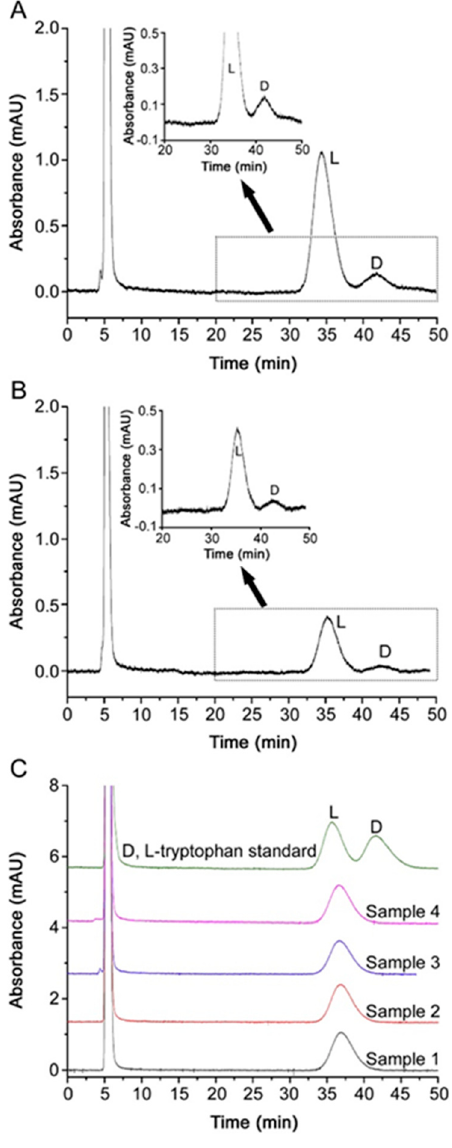
Figure 2. Chromatograms corresponding to ( A ) the LOD (7.5 µM) and ( B ) the LOQ (25 µM) of d-tryptophan; ( C ) FMOC-derivatized racemic tryptophan standard solution and analyzed dietary